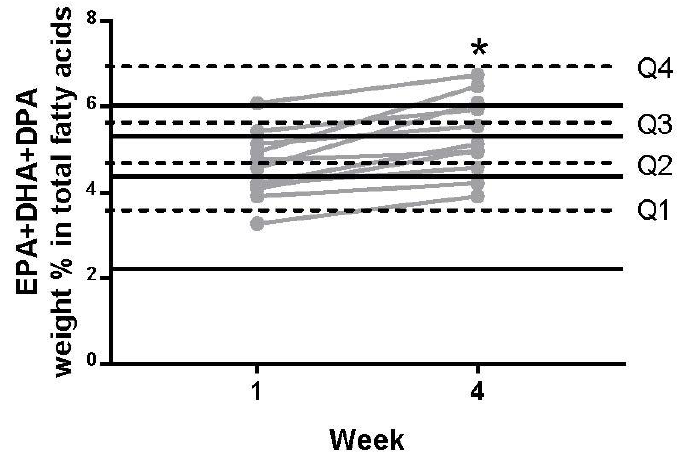
Figure 2. Percentage weight of whole blood fatty acids as combined EPA, DHA, and DPA represented as individual data points in W1 and W4. Each subject’s data are connected by a grey line. * indicates significantly different from W1 ( p < 0.05). Quartiles for cardiac risk were taken from the literature [17,30] .